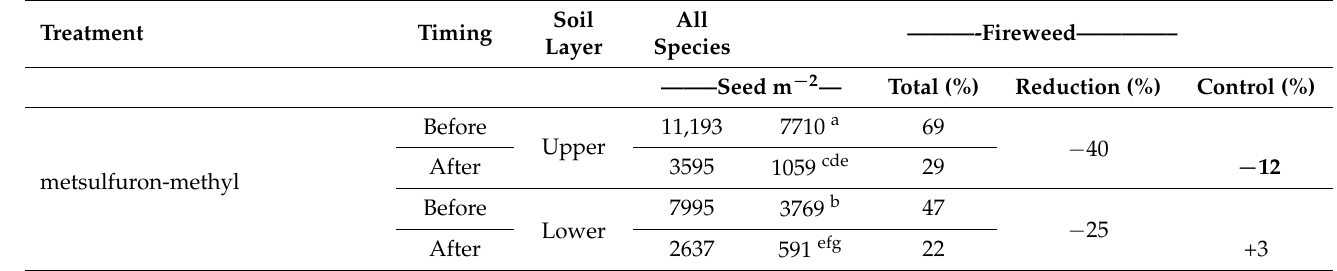
Table 4. Germinable seed density of fireweed from a kikuyu pasture at Beechmont, Queensland, before and after herbicide treatments compared with total seed density, the percent of total seed density, and the percent reduction of fireweed seed number after herbicide treatment, and reduction in seed density as compared with non-treated control plot. The measurements were taken before and after herbicide treatment and then determined for two soil layers (0 to 2 cm depth and 2 to 10